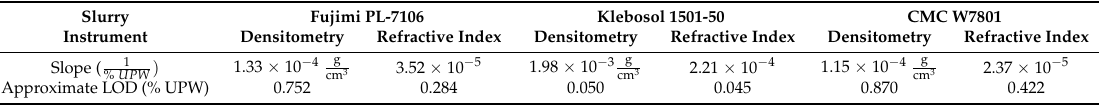
Figure 5. Correlation between density and average refractive index for ( a ) Fujimi PL-7106; ( b ) Klebosol 1501-50; and ( c ) CMC W7801. 1501-50; and ( c ) CMC W7801. Table 2. Calculation of the approximate minimum detectable change in UPW